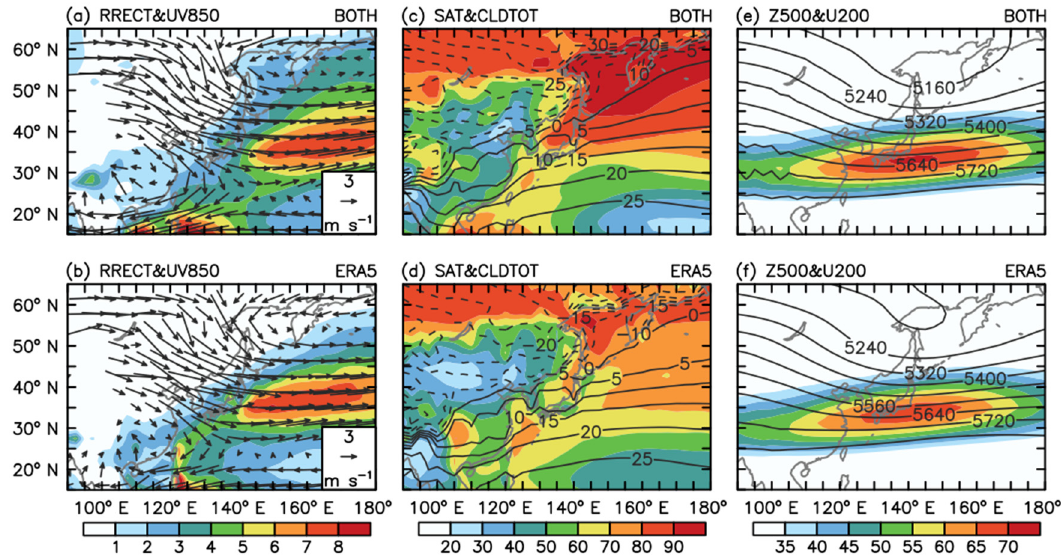
Figure 2. Climatological NDJ-mean ( a , b ) total precipitation (PRECT; color shading, in mm/day) and 850 hPa horizontal winds (vectors, in m/s); ( c , d ) surface air temperature (SAT; contours, in ◦ C) and total cloud fraction (CLDTOT; color shading, in %), and ( e , f ) 500 hPa geopotential height (Z500; contours, in gpm) and 200 hPa zonal wind (U200; color shading, in m/s) in East Asia averaged over ( a , c,e ) the last 20 years from the BOTH experiment and ( b , d,f ) 2000–2020 from the ERA5 data. The spatial pattern correlations of PRECT, 850 hPa U and V, SAT, CLDTOT, 500 hPa Z, and 200 hPa U between BOTH and ERA-Interim are 0.94, 0.95, 0.89, 0.99, 0.99, 0.99, and 0.99, respectively.